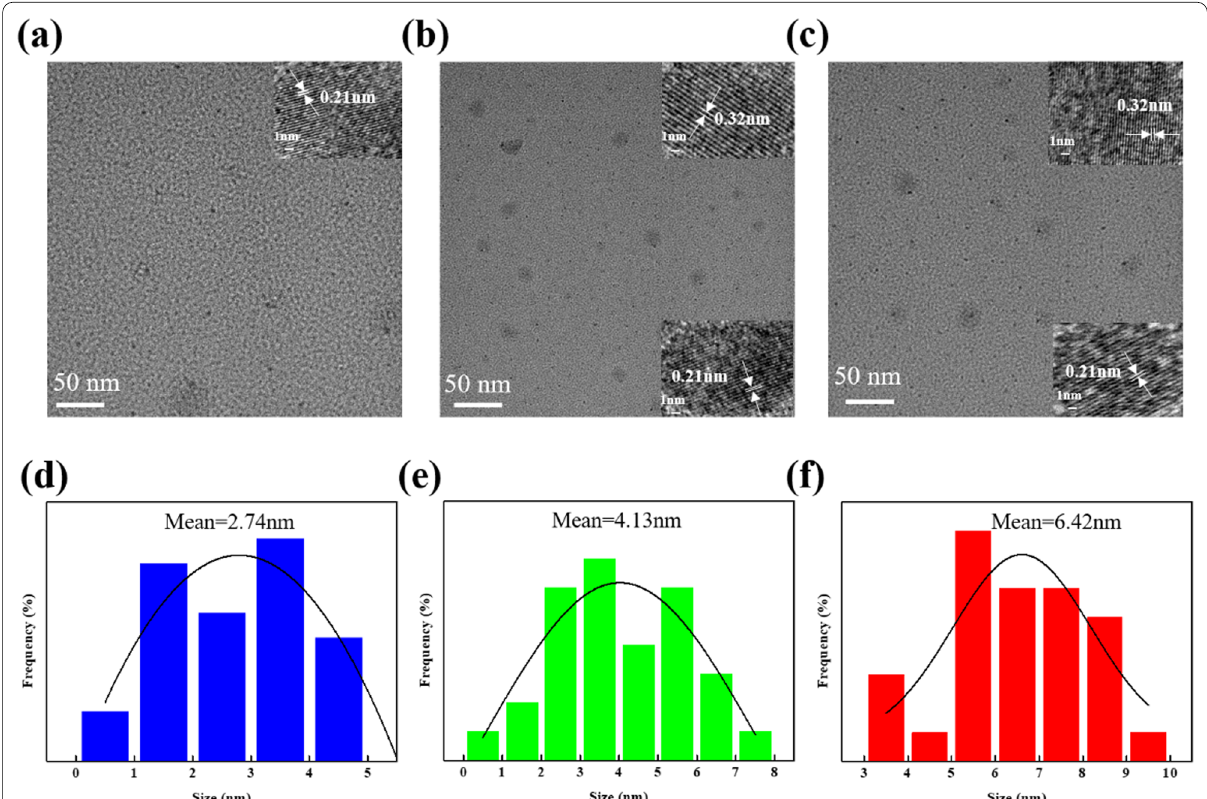
Fig. 2 TEM images of b-CDs ( a ), g-CDs ( b ) and r-CDs ( c ). Insets specify the HRTEM images. The histograms of size distribution of b-CDs ( d ), g-CDs ( e ) and r-CDs ( f